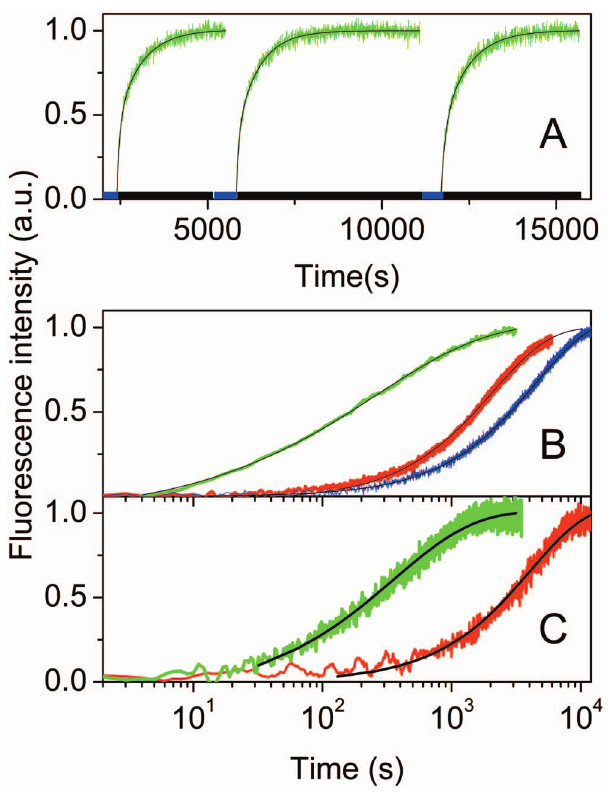
Figure 1. Dark recovery kinetics of YtvAL to YtvAD. A. Dark recovery of YtvAL to YtvAD in E. coli colonies expressing YtvA deposited on a glass coverslip, after 5 minutes illumination with LED465, monitored through fluorescence emission of YtvAD. The blue bars indicate illumination periods with LED465, black bars indicate that colonies were kept in the dark. T=25 u C. B. Dark relaxation of YtvAL to YtvAD, as monitored by the recovery of fluorescence emission after switching off LED465. Blue, buffered YtvA solution; red, E. coli colonies expressing YtvA soaked in 10 mM phosphate buffer solution, contain- ing 0.9% NaCl (W/V), pH=7.4; green, E. coli colonies expressing YtvA smeared on a glass coverslip. T=25 u C. Black solid lines correspond to fits with a stretched exponential relaxation ( E. coli colonies expressing YtvA smeared on a glass coverslip) or with an exponential decay (YtvA solution and bacteria soaked in a buffer). C. Dark relaxation of YtvAL to YtvAD after 5 minutes illumination with LED465 of B. subtilis colonies expressing YtvA. Green curves were measured for colonies smeared on a glass plate, red curves were obtained for colonies soaked in an isotonic buffer. Black curves are the best fits with an exponential decay (colonies soaked in a buffer) or a stretched exponential decay (colonies smeared on a glass plate). Fitting parameters are reported in Table